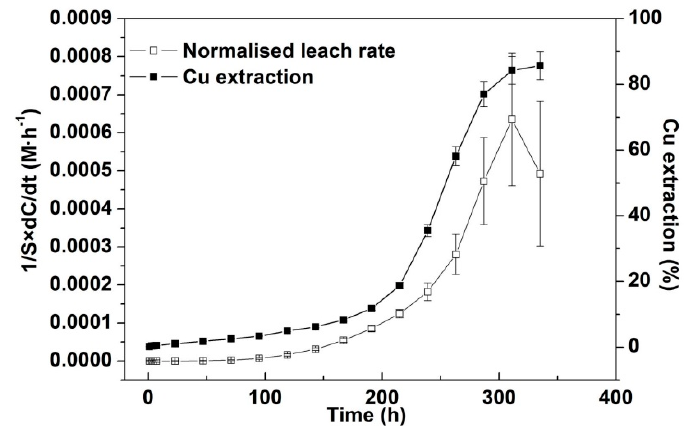
Figure 5. Relative surface area normalised leach rate and Cu extraction (%) against leach time for leaching at pH 1.0, 43 °C and 750 mV without iron addition. The large estimated errors for the last few data points are due to error propagation based on both experimental and fitting errors.